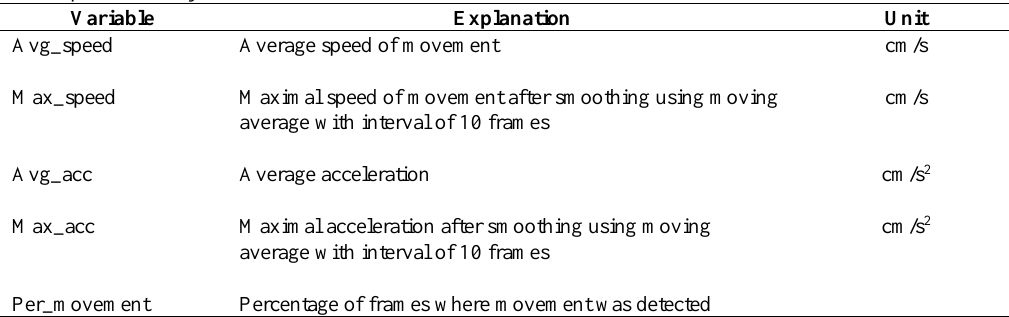
Description of Analyzed